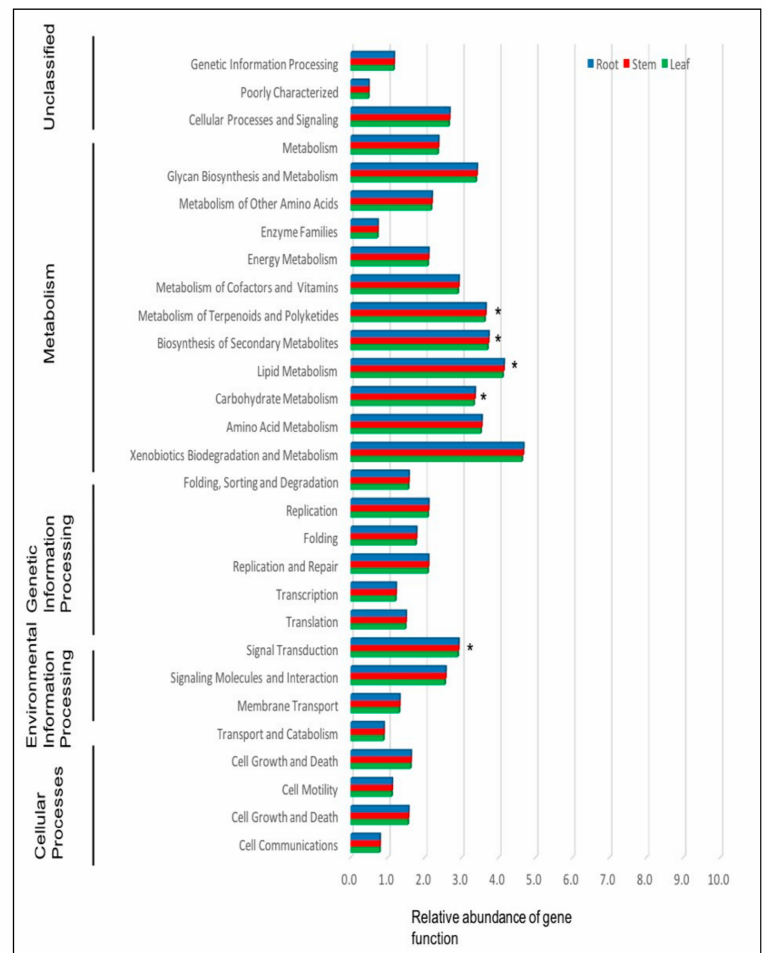
Figure 5. Predicted functions (level 2 KEGG orthology group) of the endophytic bacteria in di ff erent plant tissues of Pseudowintera colorata . An asterisk indicates gene functions that are significantly di ff erent (LSD, P <